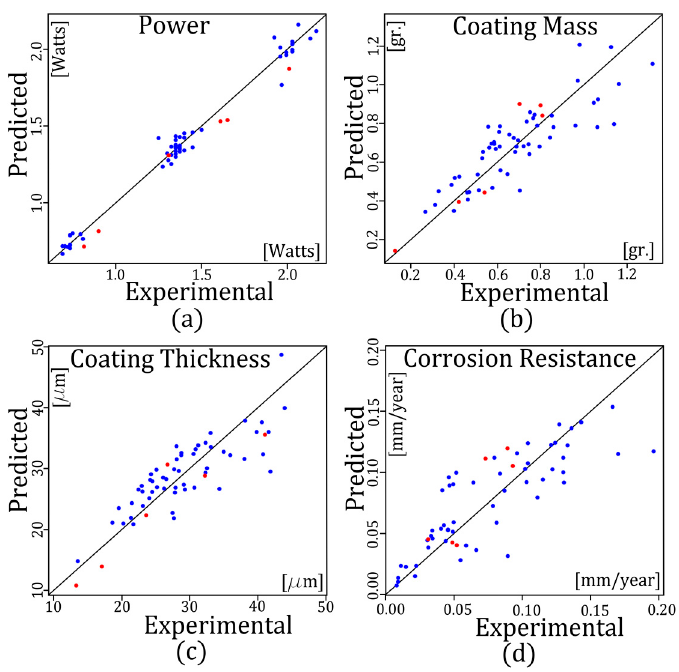
Figure 5. Scatter diagram of ( a ) power consumed ( W ), ( b ) coating thickness ( Th ), ( c ) increase in coating mass ( Δ M ), and ( d ) corrosion resistance ( R ).